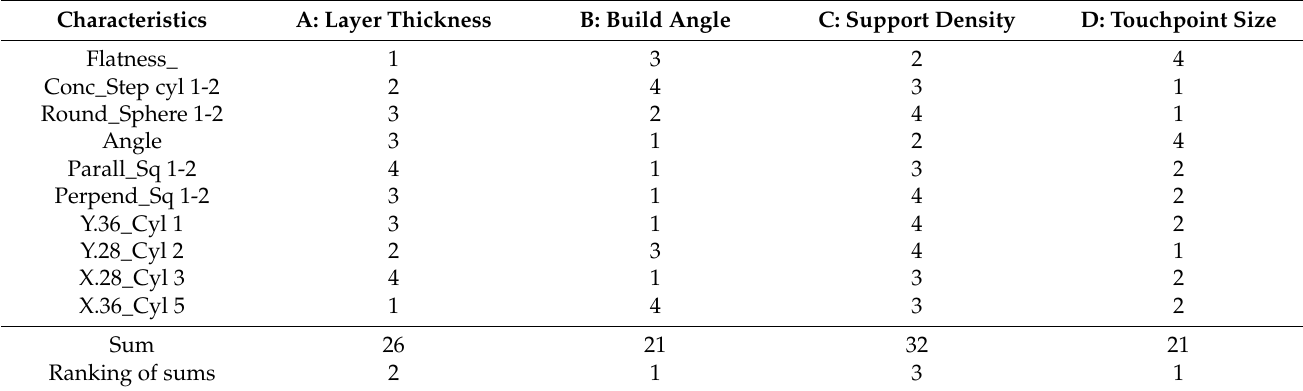
Table 20. S/N ratio ranking of parameters for geometric characteristic of cast parts.